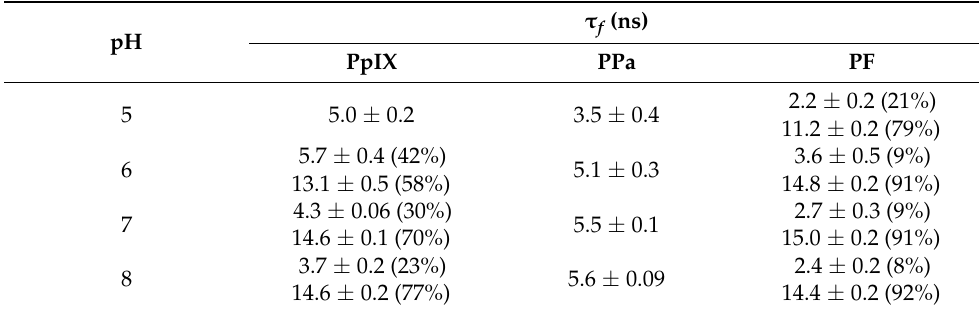
Table 10. Fluorescence lifetimes of PpIX, PPa, and PF in PBS ( λ exc = 408 nm, c = 3.1 µ M) at room